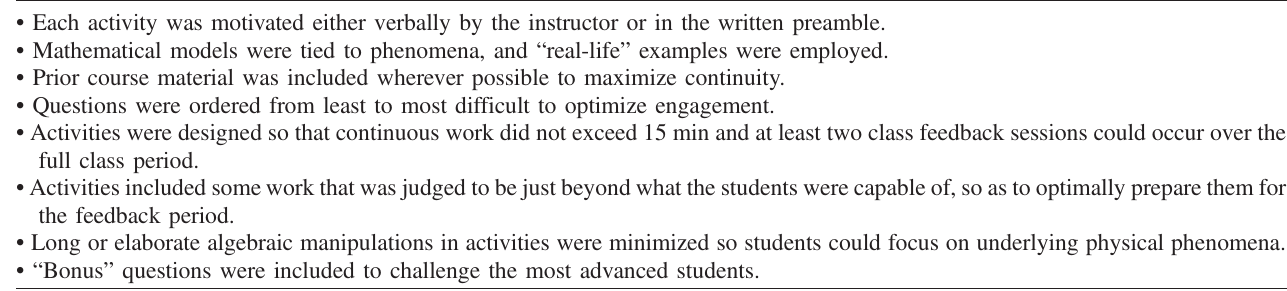
TABLE I. Design considerations used for this course